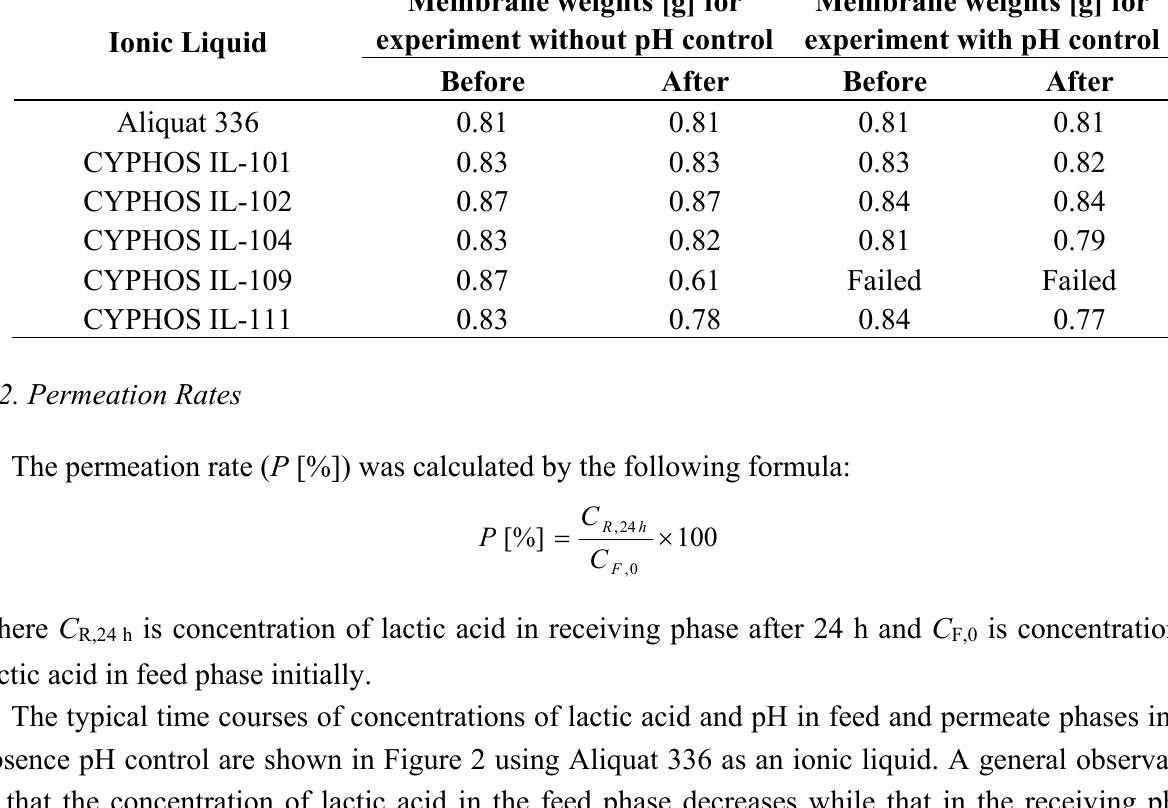
Table 2. Membrane weights before and after transport